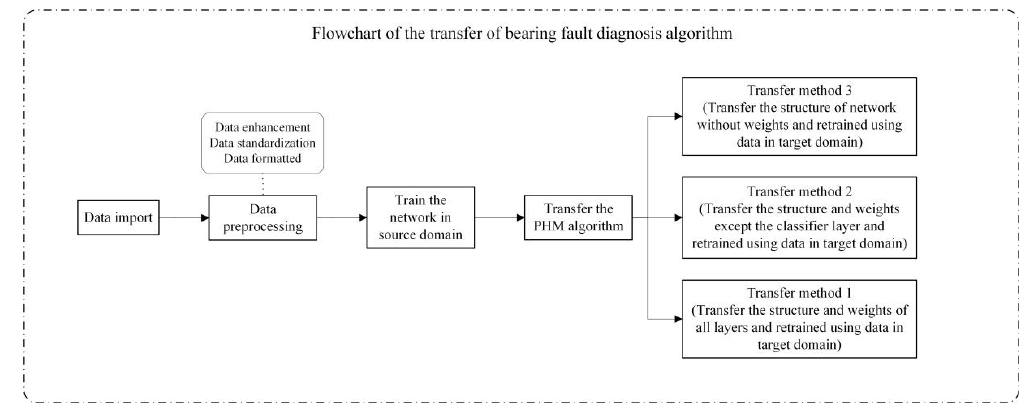
Figure 7. Flowchart of bearing fault diagnosis algorithm